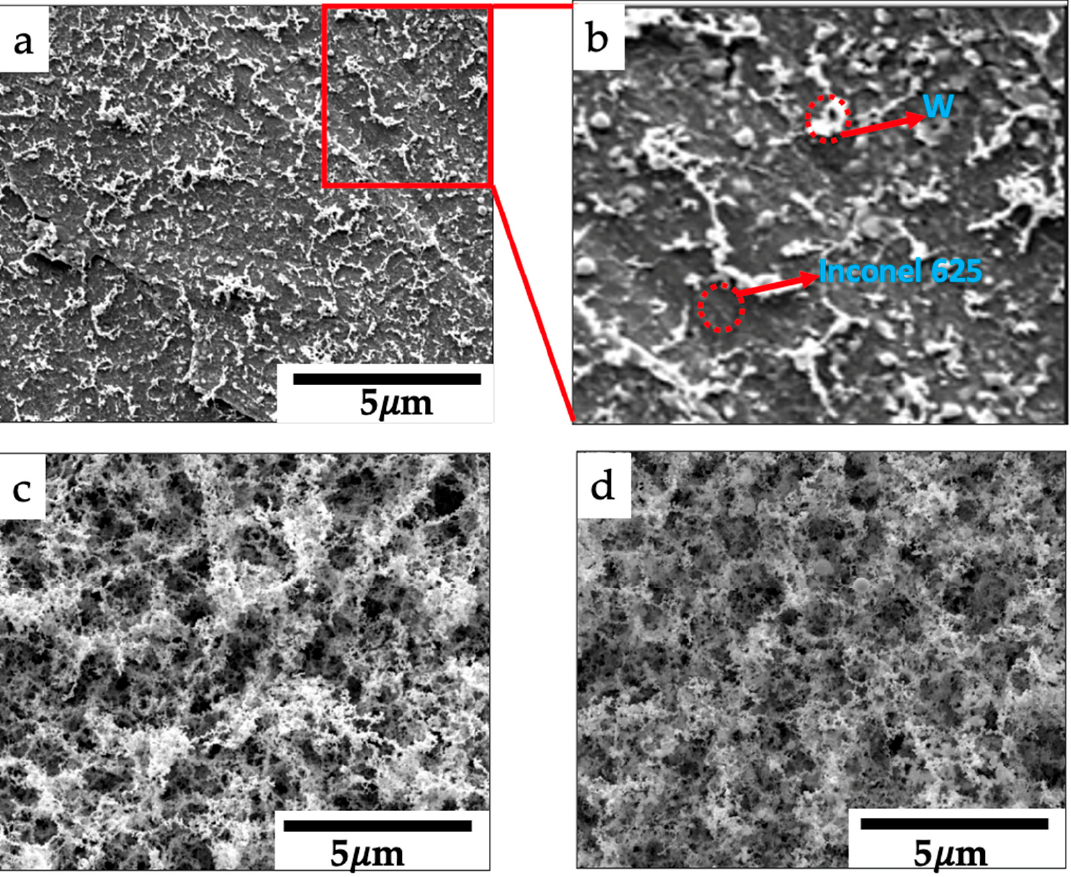
Figure 5. Surface morphology of samples converted at different laser beam powers and heat-treated at 900 ◦ C using SEM: ( a ) C1, ( b ) zoomed in micrograph of C1(highlighted area), ( c ) C2, and ( d ) C3.